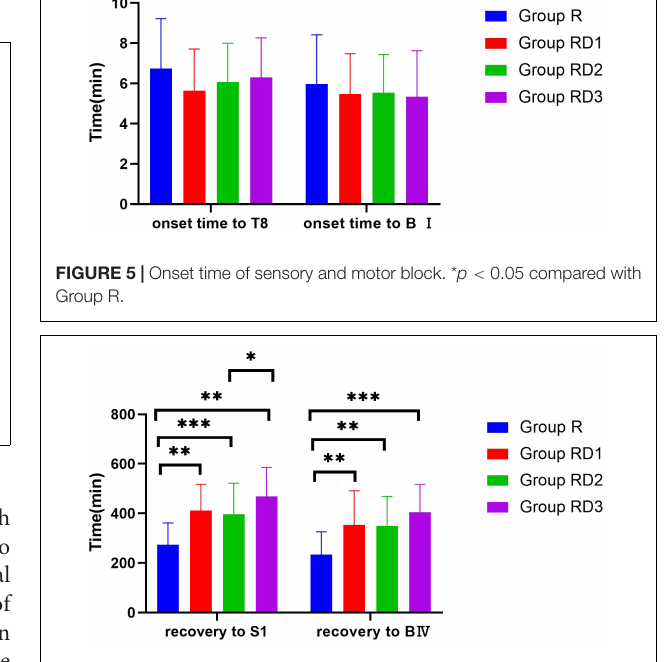
FIGURE 6 | Recovery time of sensory and motor block. ∗ p < 0.05, ∗∗ p < 0.01, ∗∗∗ p <